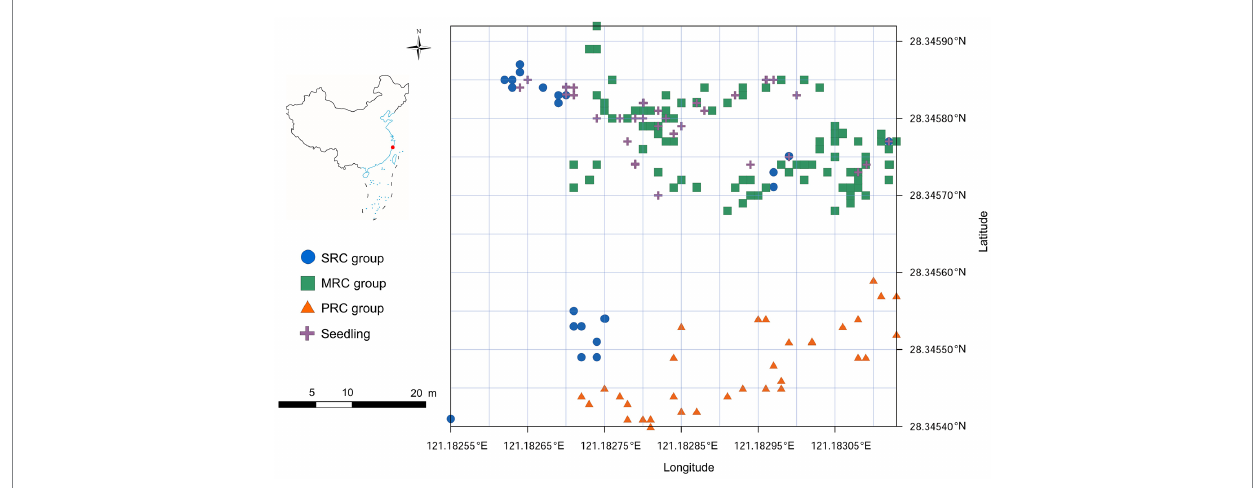
FIGURE 1 Location of the study area in China and distribution of Kandelia obovata individuals in YQ population. The horizontal axis represents longitude and the vertical axis represents latitude. SRC: individuals with strong resistance to cold; MRC: individuals with moderate resistance to cold; and PRC, individuals with poor resistance to